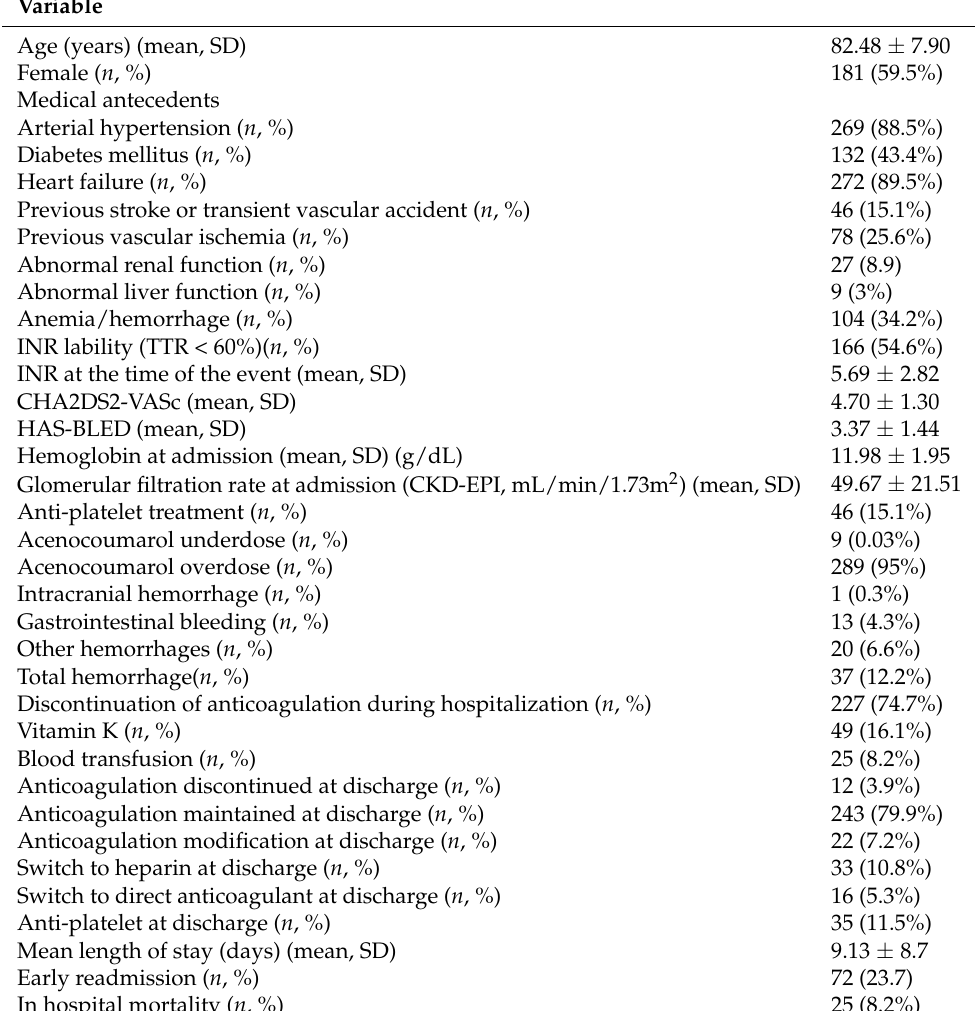
Table 1. Clinical characteristic in patients with heart failure (HF) and adverse reaction